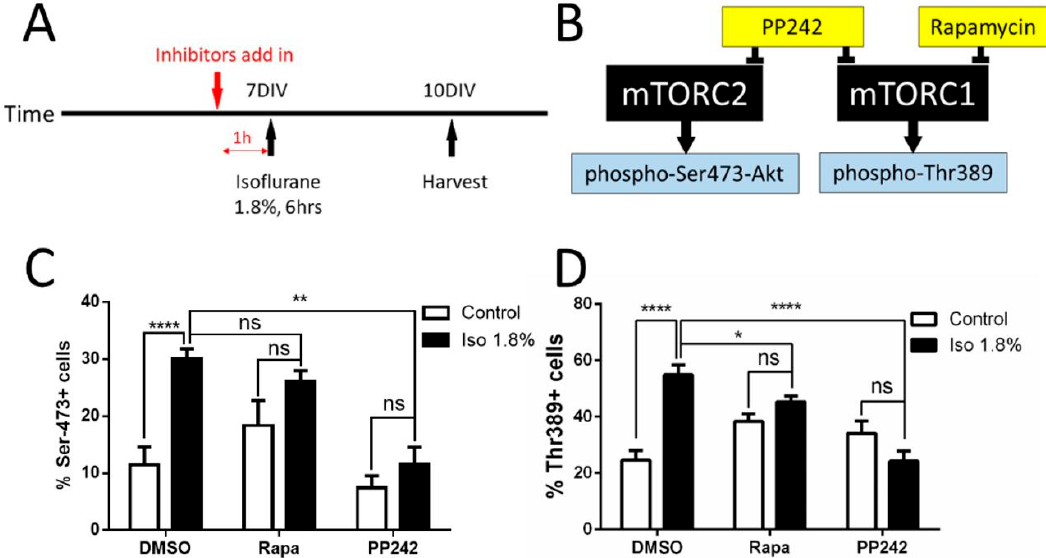
Figure 5. Effects of 1.8% isoflurane exposure for 6 h on the downstream marker of mTORC1 and mTORC2 pathway. ( A ) The timeline for adding mTORC1/mTORC2 inhibitors. The inhibitors